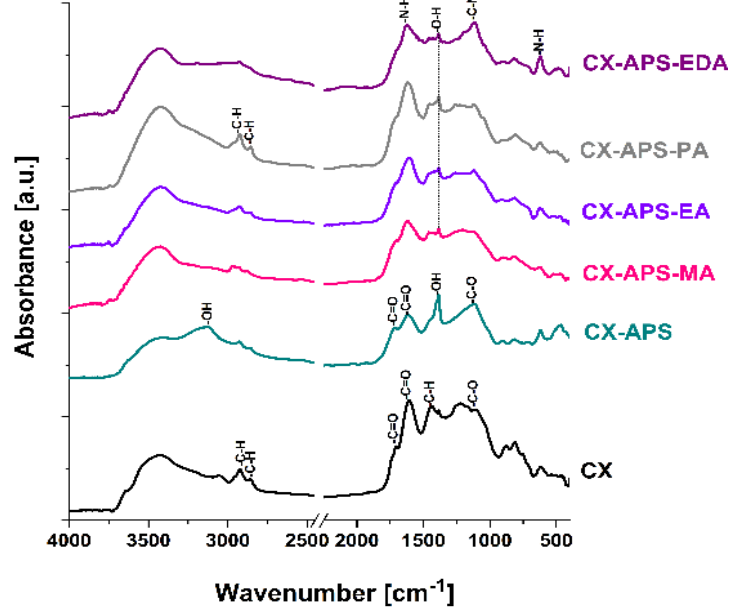
Figure 4. FT-IR spectra of samples studied.